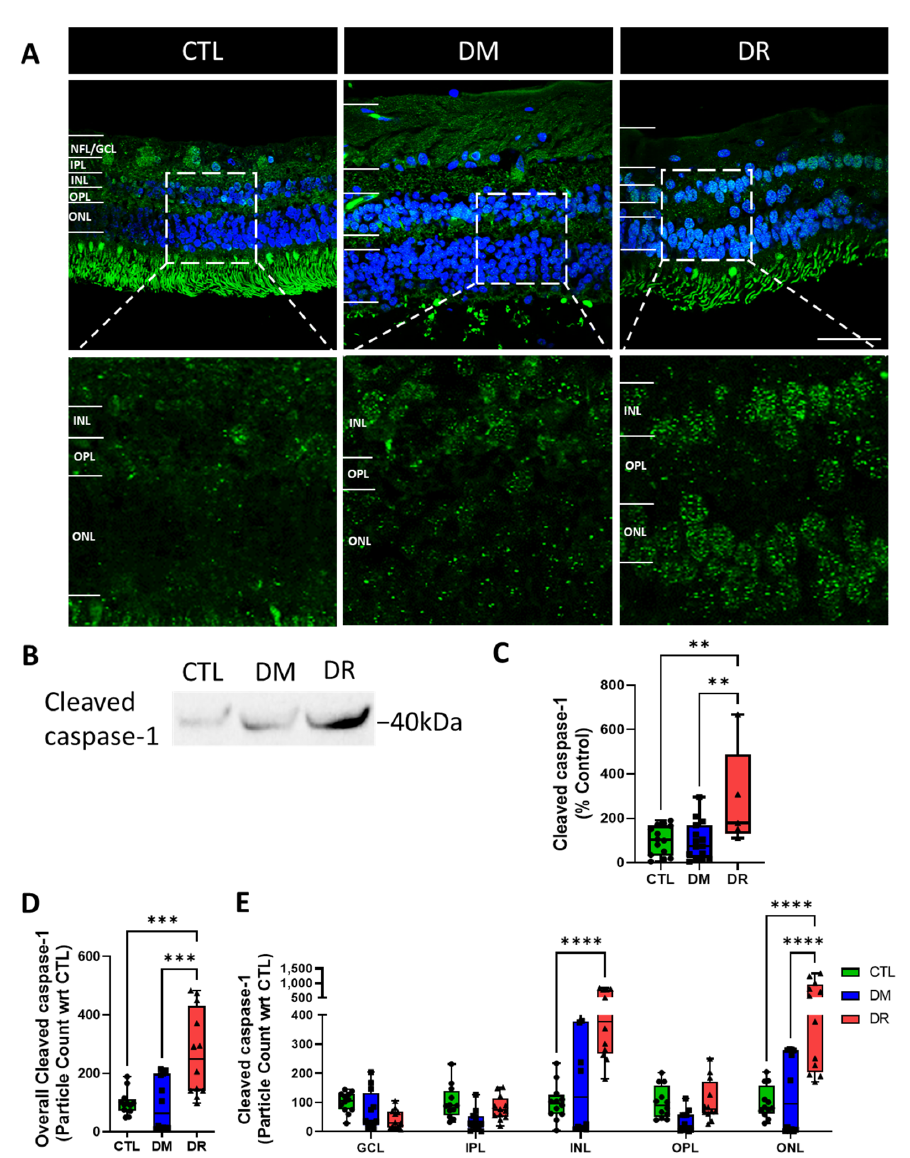
Figure 5. Cleaved caspase-1 significantly increased in DR in the INL and ONL. ( A ) Immunohistochemical labelling of cleaved caspase-1 showed increased expression levels from CTL to DM to DR. Specifically, expression of cleaved caspase-1 was localized in nuclei in the INL and ONL ( B ) Western blotting analysis also found increased cleaved caspase-1 levels from CTL to DM to DR. ( C ) Quantification of bands showed no difference in cleaved caspase-1 expression between CTL and DM ( p = 0.9990) while a significant increase was found in DR compared to CTL ( p ≤ 0.01) and DM ( p ≤ 0.01). ( D ) Quantification of cleaved caspase-1 expressed in the entire retina appeared higher in DM compared to CTL but without significant difference ( p = 0.9935), with significantly higher expression in DR compared to CTL ( p ≤ 0.001) and DM ( p ≤ 0.001). ( E ) Similarly, quantification of cleaved caspase-1 expressed in each retinal layer showed significantly higher expression in DR compared to CTL ( p ≤ 0.0001) and DM ( p ≤ 0.0001) in the INL and ONL, while minimal expression was found in other retinal layers across all groups. Inserts of immunohistochemical images are presented in the bottom row at 3 × magnification of the top row. Scale bar = 50 µ m. Statistical analysis was carried out using one-way ANOVA for expression in the entire retina and Western blotting, and two-way ANOVA for expression in each retinal layer. ** p ≤ 0.01; *** p ≤ 0.001; **** p ≤ 0.0001. Data point of each patient in CTL, DM and DR are marked as circle, square and triangle,